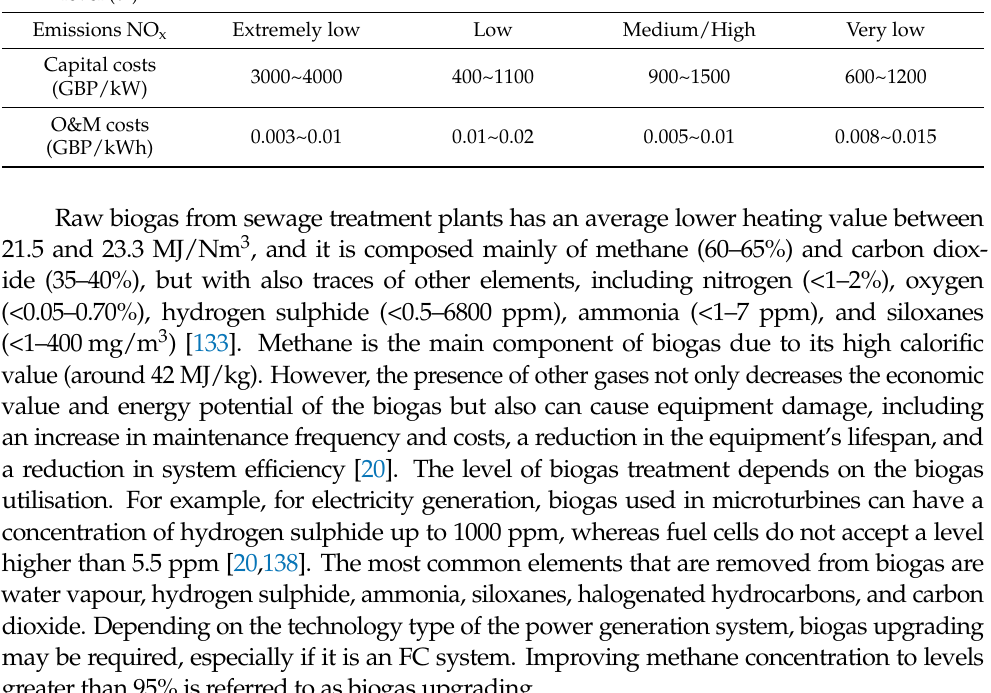
Table 7. Biogas utilisation in some countries from landfills, WWTPs, agricultural, industrial, and bio ‐ waste plants. Country